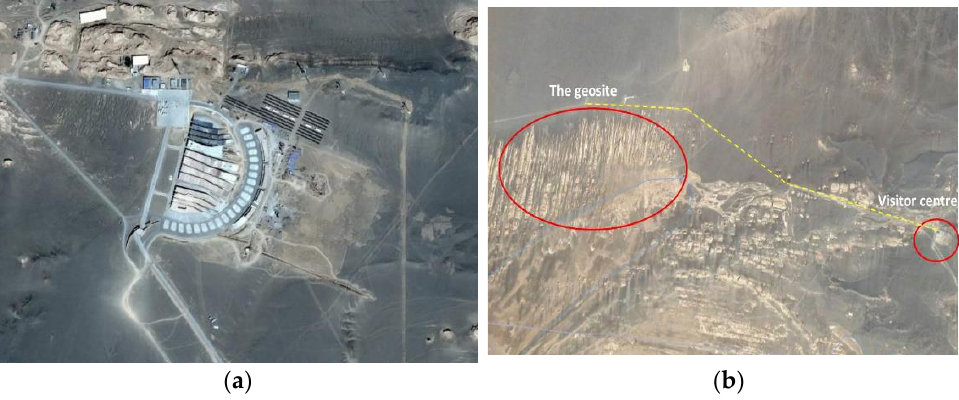
Figure 3. ( a ) Visitor centre/ticket office of the Yardang National Geopark (from Google Earth Pro V 7.3.4 (11 February 2019), 40 ◦ 30 (cid:48) 37.58 (cid:48)(cid:48) N, 93 ◦ 14 (cid:48) 18.91 (cid:48)(cid:48) E, Eye alt 5.12 km, CNES, Airbus, Maxar Technologies 2022, [46]); ( b ) the yellow hatch indicates the road that leads from the visitor centre of the Yardang National Geopark to the geosite (from Google Earth Pro V 7.3.4 (20 May 2019), 40 ◦ 31 (cid:48) 34.67 (cid:48)(cid:48) N, 93 ◦ 09 (cid:48) 21.53 (cid:48)(cid:48) E, Eye alt 25.22 km, CNES, Airbus, Terrametrics 2022, [46], modified).